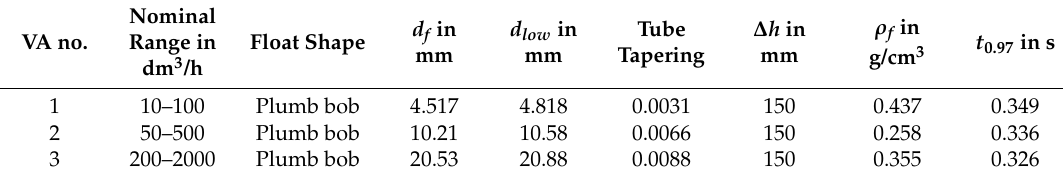
Table 3. Tube and float optimization results.